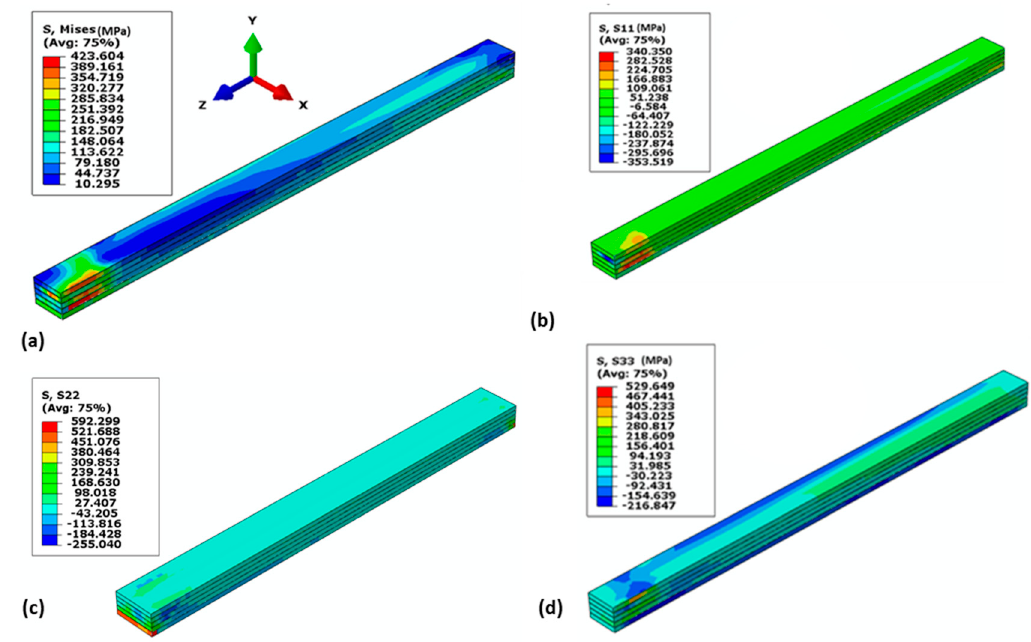
Figure 15. Contour plots of residual stress within deposition (cross-section). ( a ) Von mises stress. ( b ) Normal stresses along the beam scan direction (S11, along X-axis), ( c ) normal stresses along the beam penetration direction (S22, along Y-axis), and ( d ) normal stresses along the beam scan direction (S33, along Z-axis).